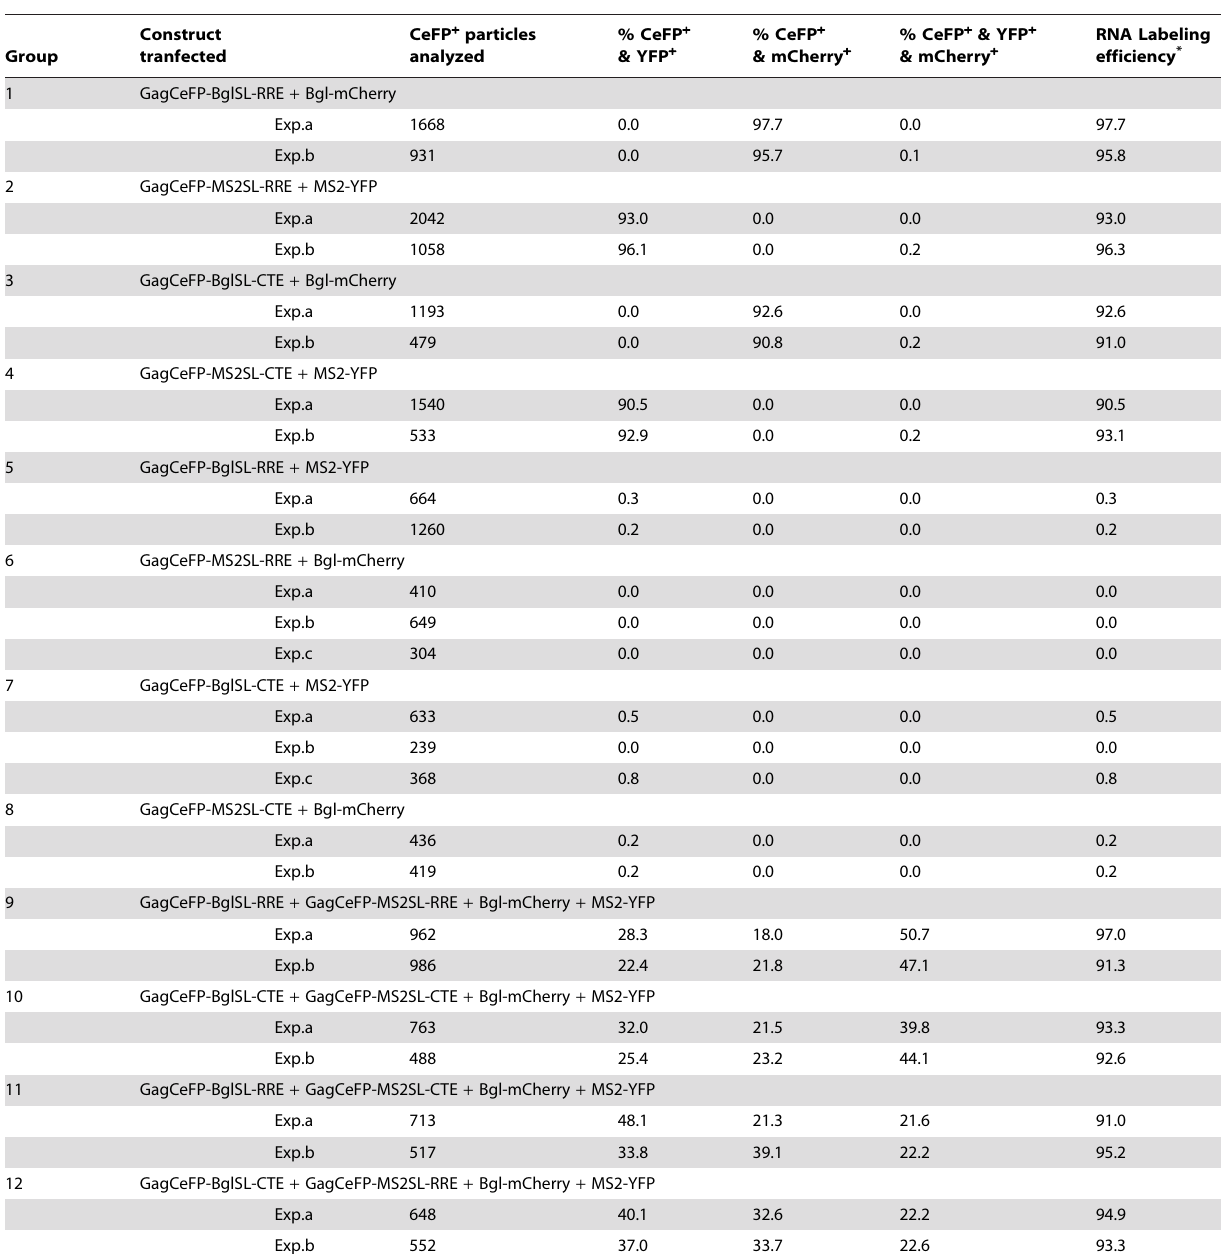
Table 1. RNA contents in viral particles by Single virion visualization.